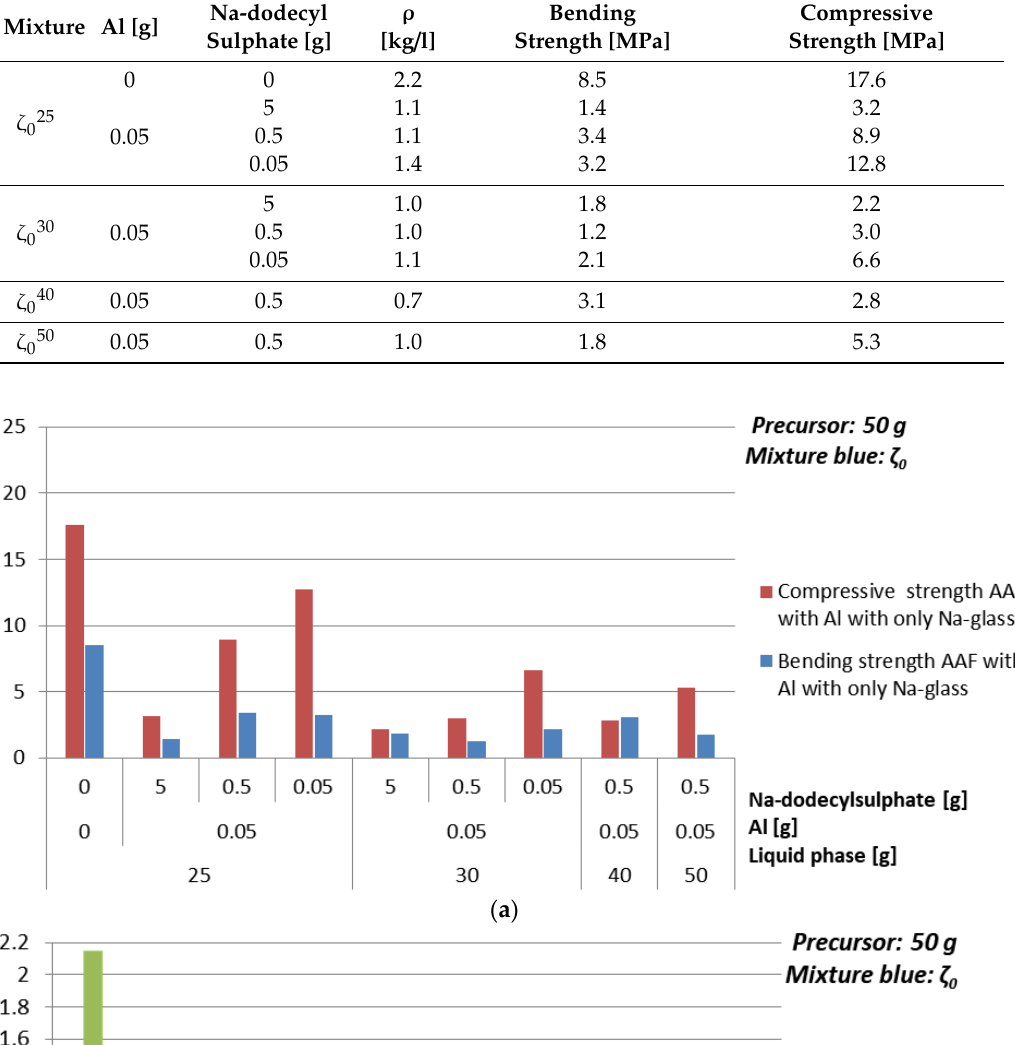
Table 14. Density, bending, and compressive strength of AAF, produced by Al powder using mixture ζ 0 , cured at 70 °C for one day, measured one week after molding. Combination of ingredients for AA resulting in literature’s highest compressive strength value is coloured .